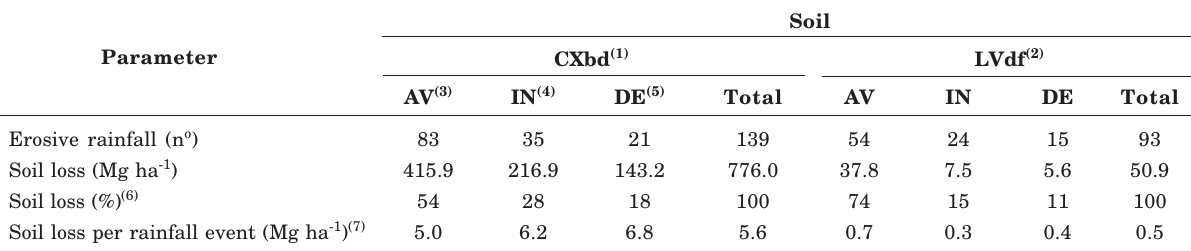
Table 2. Amount of erosive rainfall, soil loss and soil loss percentage in three different patterns of erosive rainfall events in the region of Lavras, MG